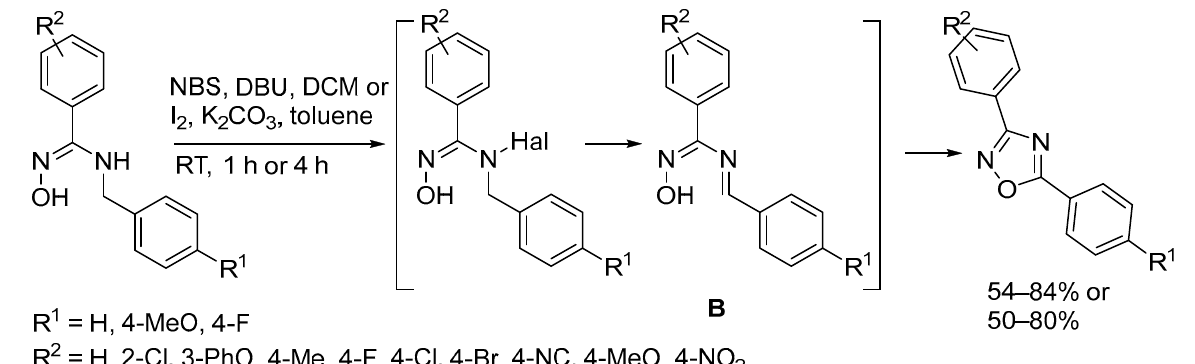
Scheme 34. Oxidative cyclization of N -benzyl amidoximes.